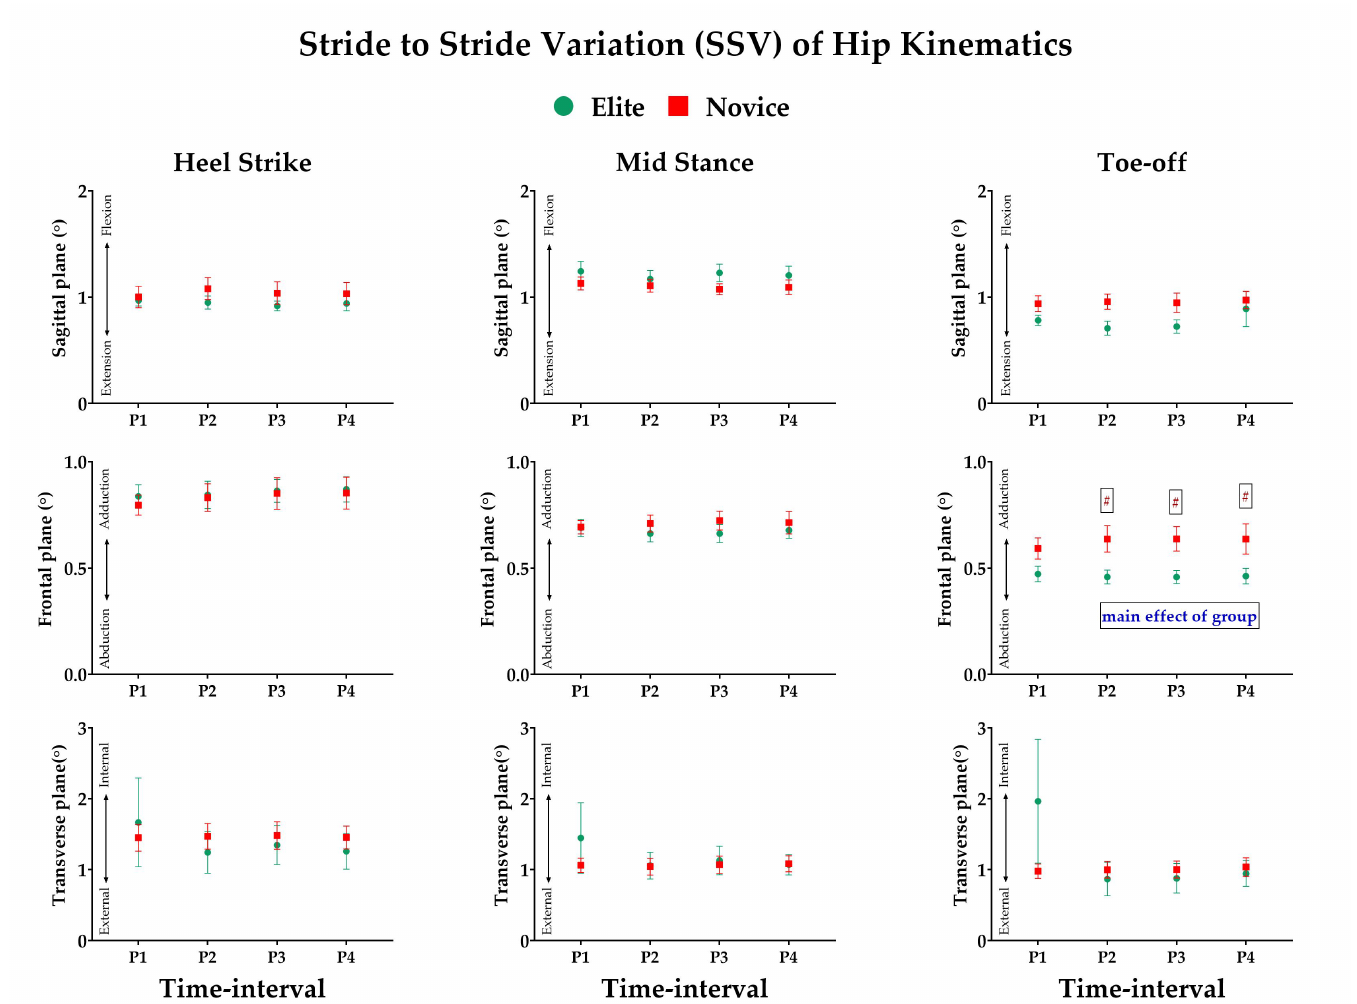
Figure A7. The result of the kinematics of hip joint SSV angle between elites (circle) and novices (square) in each phase of the prolonged run. The computed variable of SSV is represented on the Y -axis. The time-interval calculated by increasing the window size every five minutes is represented on the X -axis (P1: 0 to 5 min; P2: 0 to 10 min; P3: 0 to 15 min; and P4: 0 to 20 min). The figure depicts a significant main effect of group, time interval, and interaction. Significant differences in a group for a specific time interval are marked with a “#”. (Note: only results with significant interaction have been